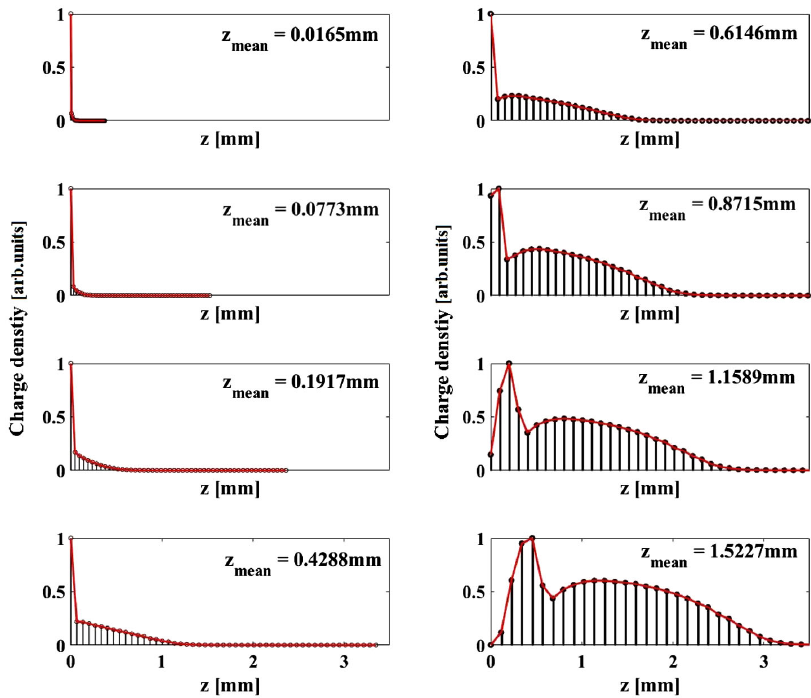
FIG. 20. Curvature formation in electron bunch profile due to space-charge effects during photoemission. The inset numbers show the mean bunch positions at different moments in the emission